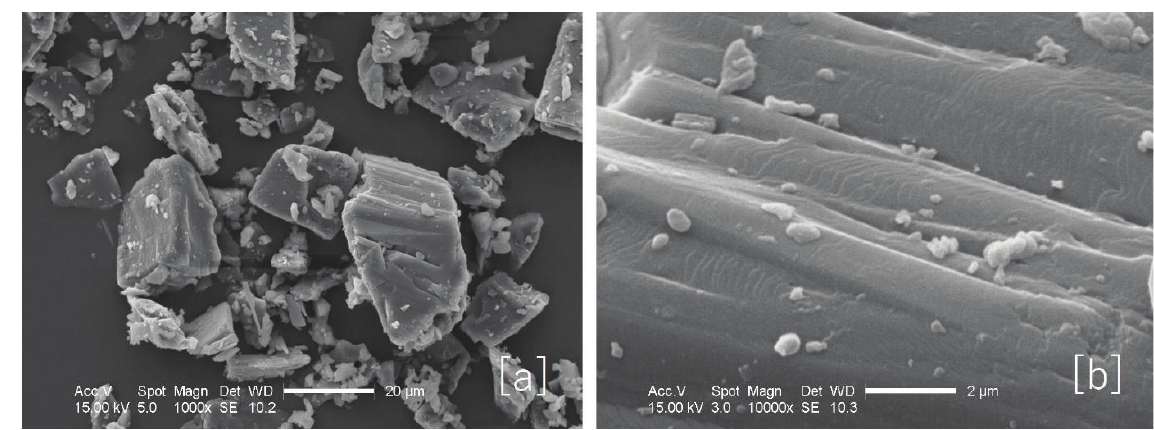
Grinding sodium bicarbonate, apart from developing its surface area, decreased the temperature of its decomposition. The thermogravimetric analysis showed that the maximum decomposition of the sample SO took place at 431 K (peak), whereas SOm at the temperature 414 K. Fig. 4 shows the thermogravimetric analysis of Fig. 3 – Surface of the SOm grains, BSE, magnification: a) 1000x, b) 10000x the of the SOm grains, BSE, magnification: a) 1000x, b) 10000x Fig. 3 Surface